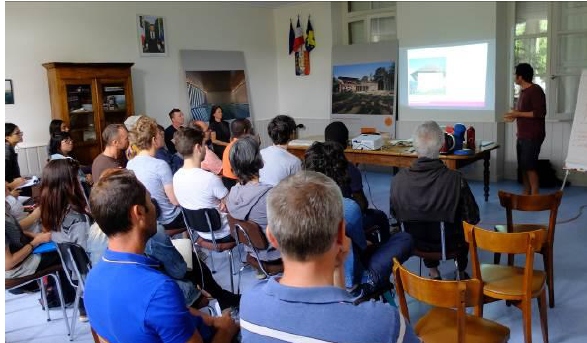
Figure 5. Training on rammed building’s diagnostic, France © CRAterre_Moriset